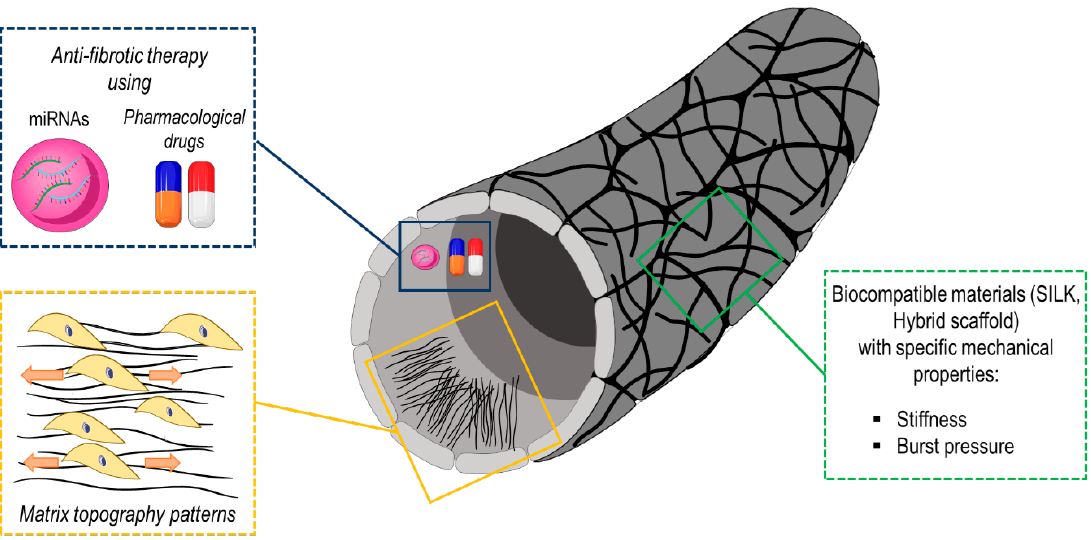
Figure 3. Mechanical properties (e.g., burst pressure, stiffness), surface modifications (e.g., matrix Figure 3. topography patterns, functionalization with specific anti-fibrotic miRNAs) and the selection of the proper biomaterial (e.g., hybrid scaffold, silk) play a crucial role in promoting maturation of vascular tissue engineered constructs.